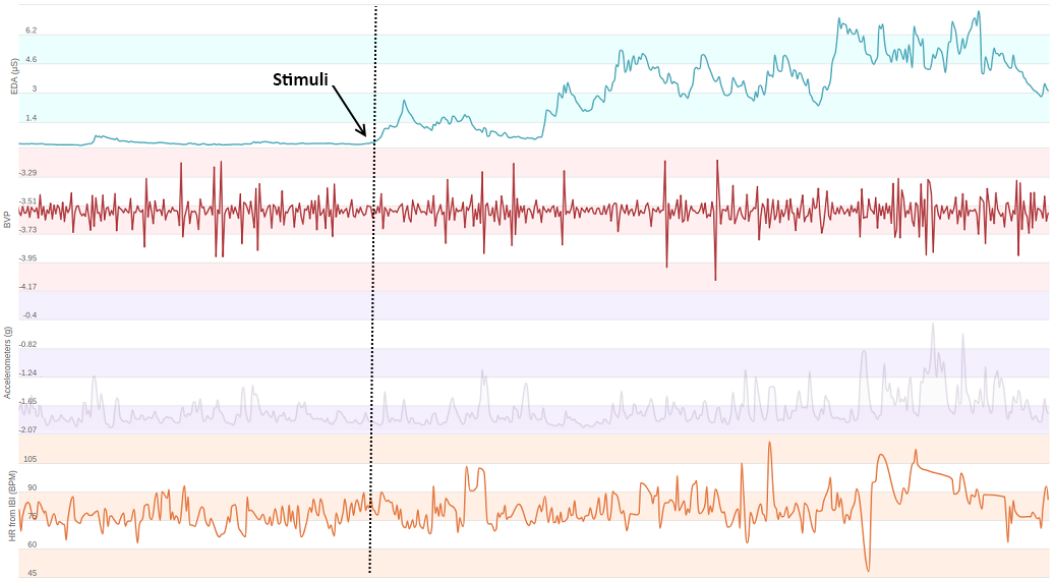
Figure 1. Recorded physiological signals before and after the start of the stimuli. The increase in EDA signal level and number of peaks and irregularities and sudden increases in HRV can be seen in this